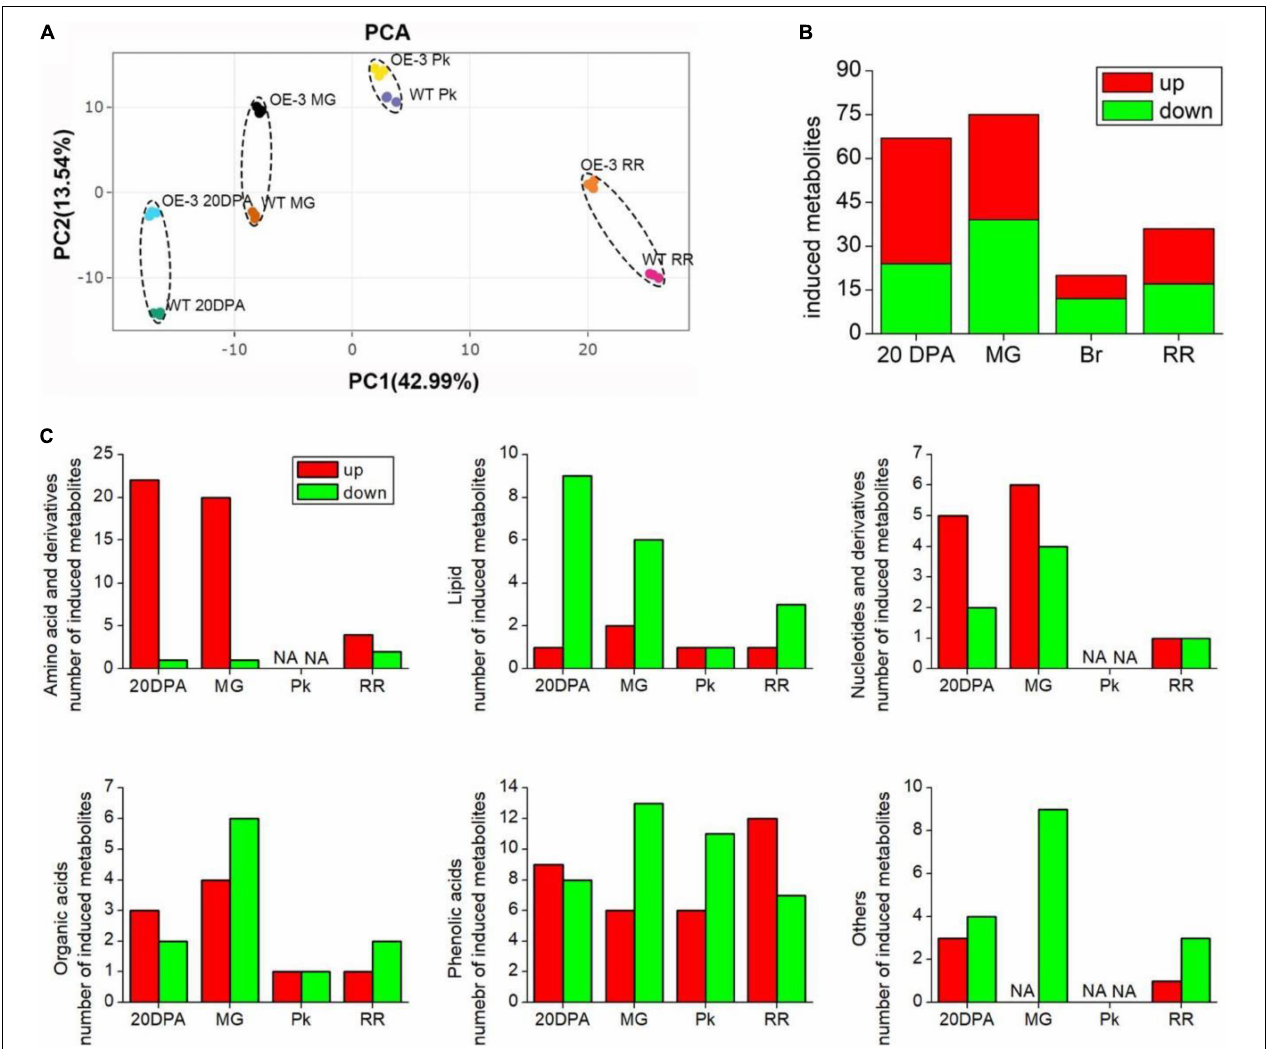
FIGURE 7 | Identification of significantly changed primary metabolites in WT and OE-3 fruits at different development stages. (A) Principal component analysis (PCA) of primary metabolites. PCA score plots (PC1 vs. PC2) for the first two principal components after SlAAE3-1 overexpression. Each sample was marked using individual color. Statistics of induced total (B) and classified (C) metabolites at different development